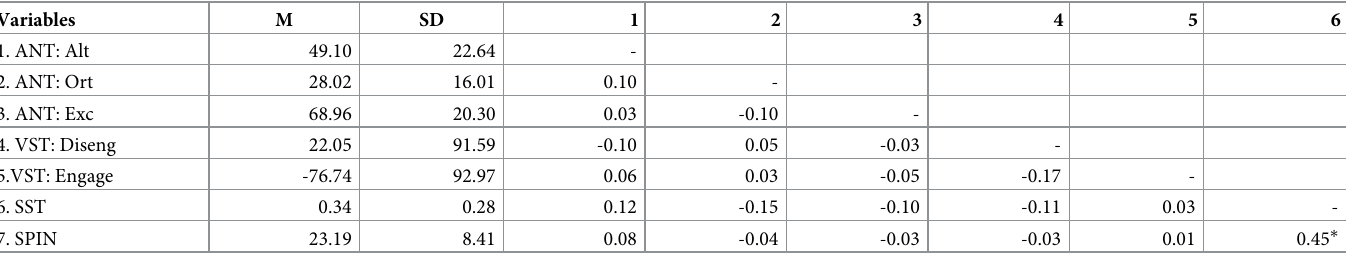
Table 1. Descriptives and correlations ( N =